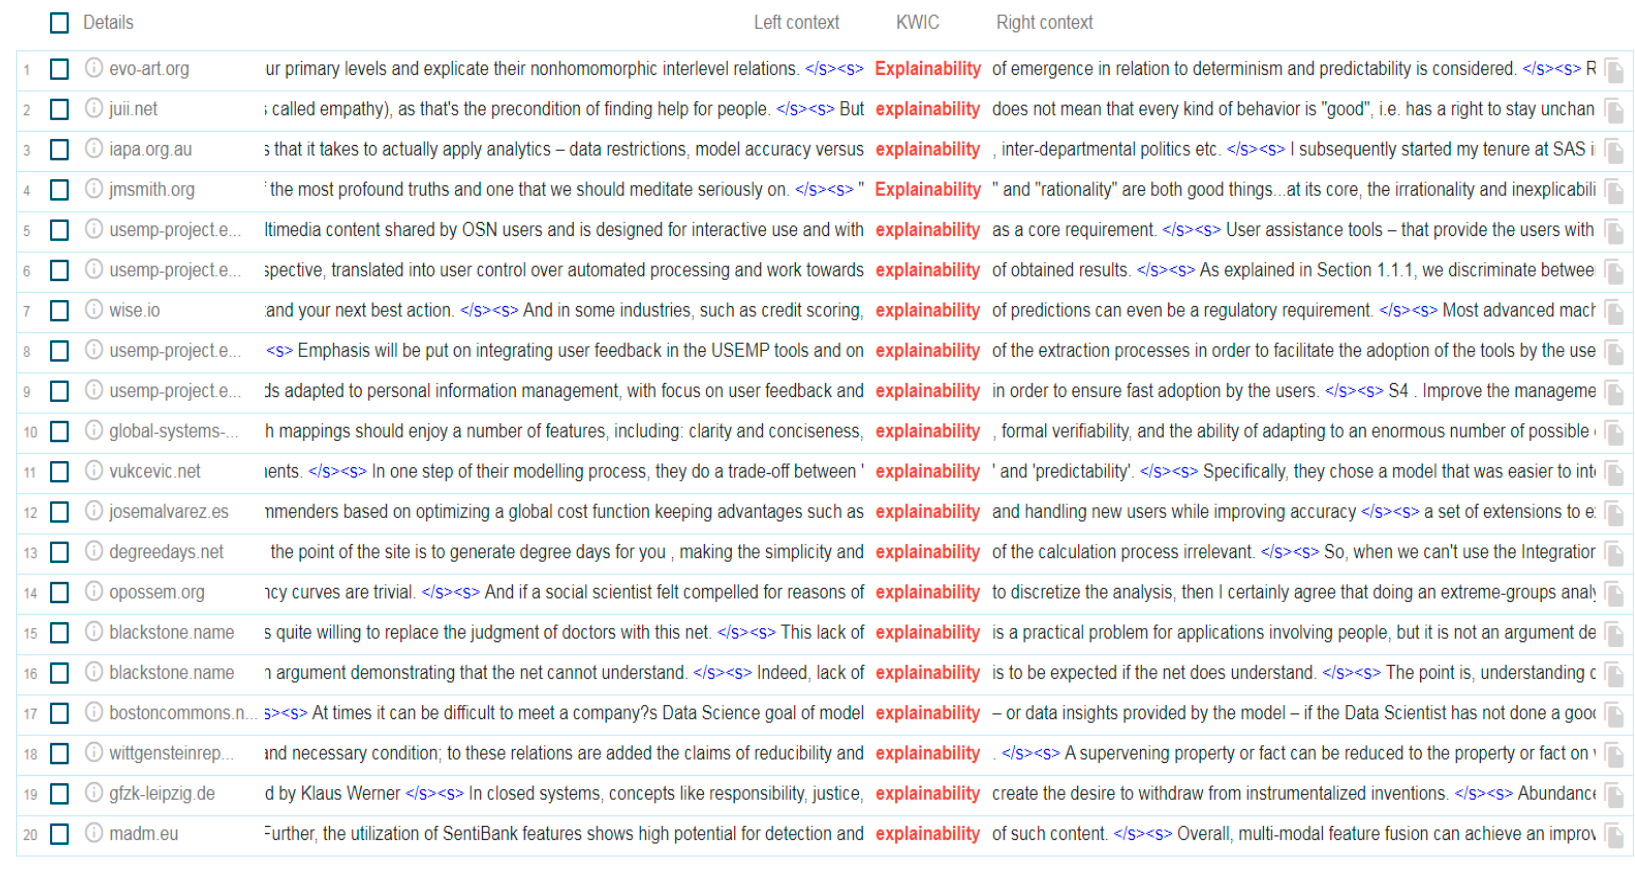
Figure 5. Concordance analysis for the term ‘Explainability’.